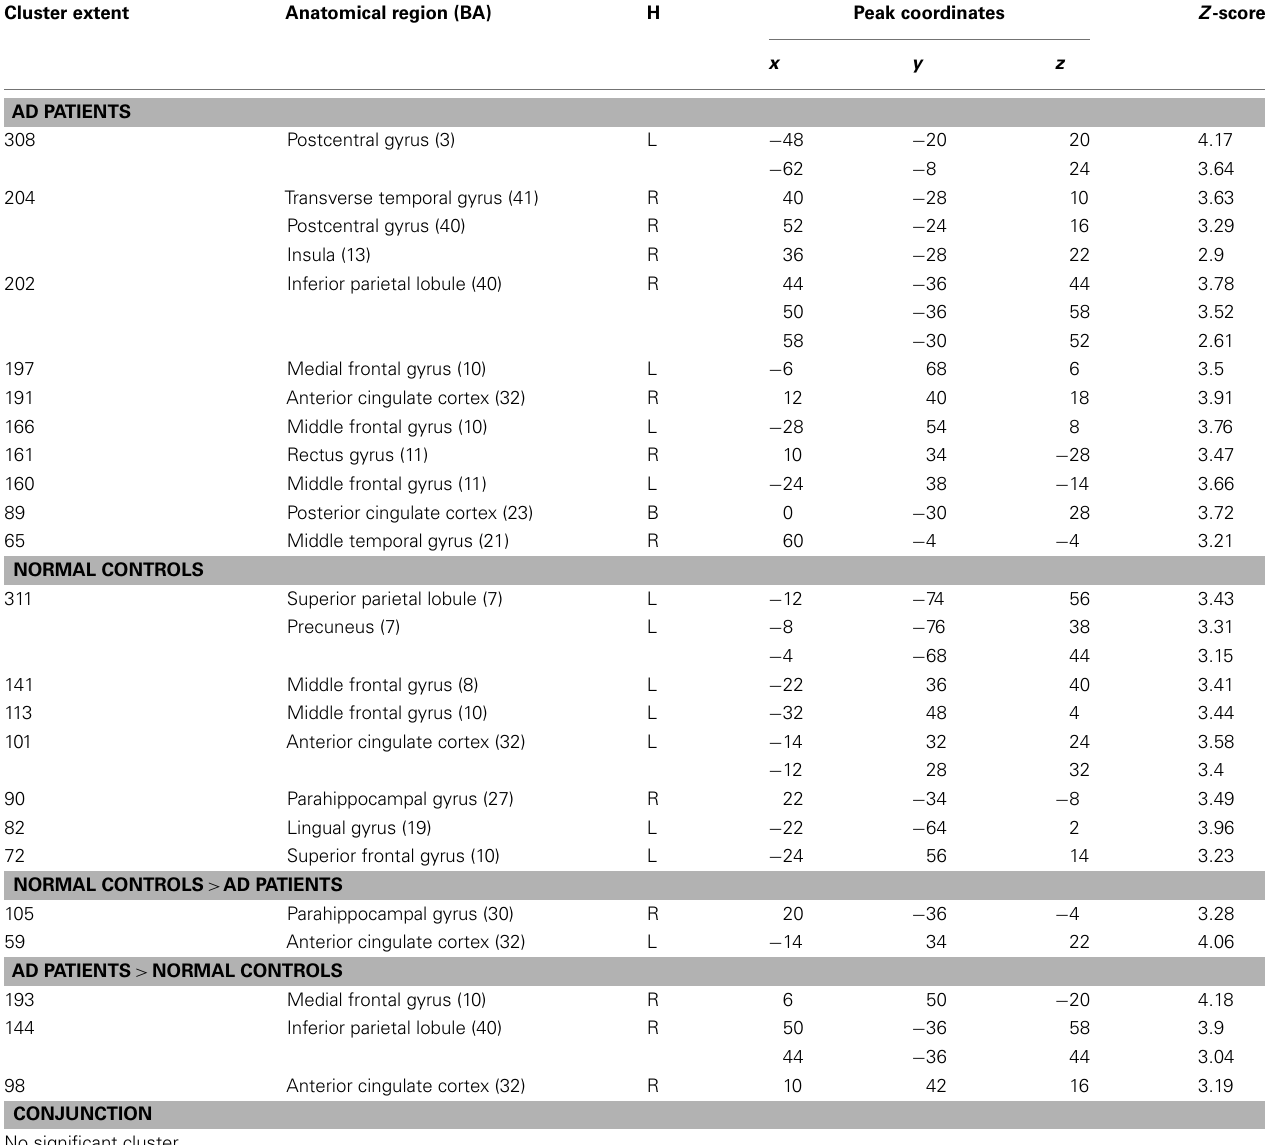
Table 1 | Significant activations for intra- and inter-group comparisons for the (encoding – reading) contrast ( p < 0.005 uncorrected, cluster extent > 50